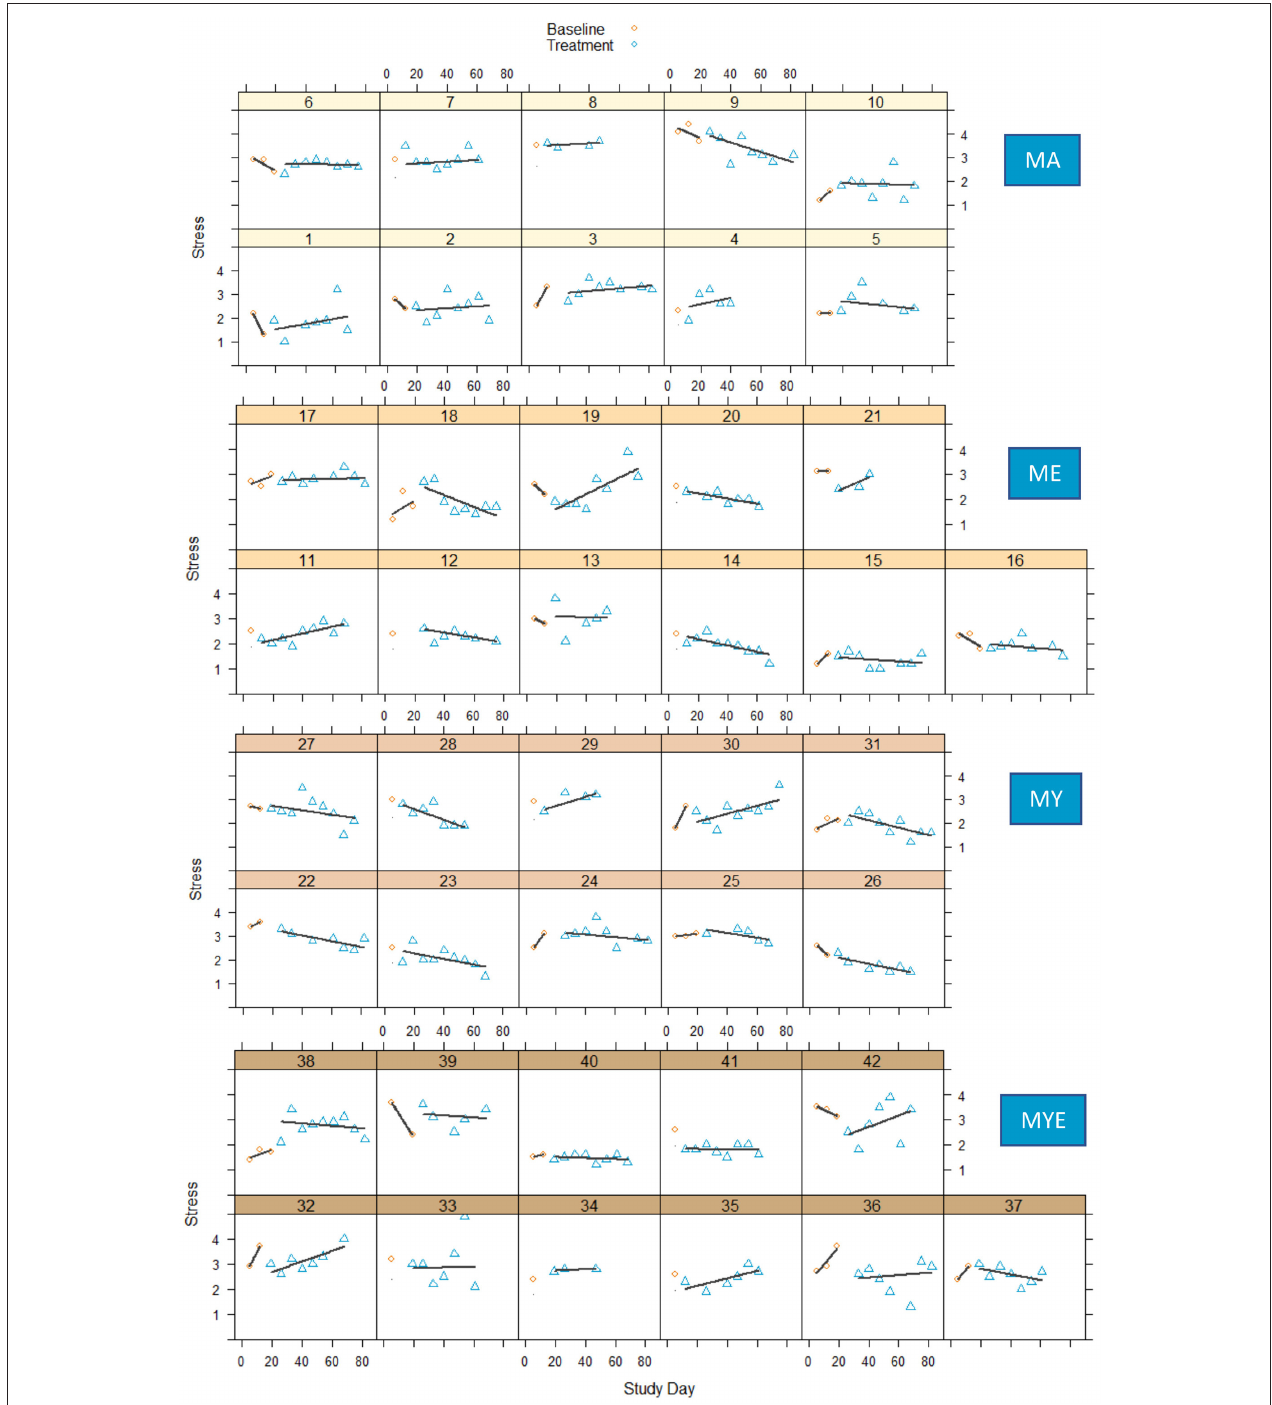
FIGURE 5 | Stress scores during baseline and treatment phases for each participant with regression lines for each phase. MA, Mantra meditation only; ME, meditation and ethical education; MY, meditation and physical yoga; MYE, meditation, physical yoga, and ethical education. differences between conditions by generating box plots for each condition ( Figure 6